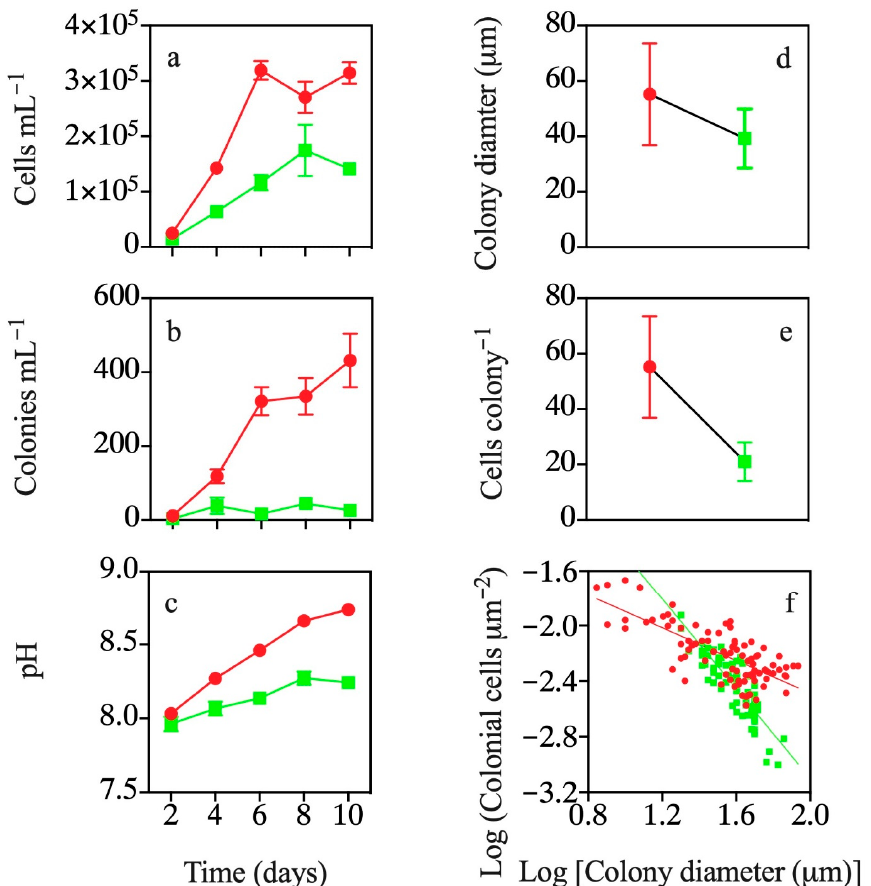
Figure 4. ( a ) The solitary cell abundances (Mean ± SD, n = 3), ( b ) the number of colonies (Mean ± SD, n = 3), ( c ) pH (Mean ± SD, n = 3), ( d ) colony diameters (Mean ± SD, n = 90 and 77 for control and treatment, respectively), ( e ) the number of cells per colony (Mean ± SD, n = 90 and 77 for control and treatment, respectively) and ( f ) linear relationship between Log (colonial cells µm − 2 ) and Log [colony diameter (µm)] (n = 90 and 77 for control and treatment, respectively) in P. globosa grown alone (red circles) and exposed to extracellular exudates of T. weissflogii pre-exposed to filtrates of P. globosa (green squares).